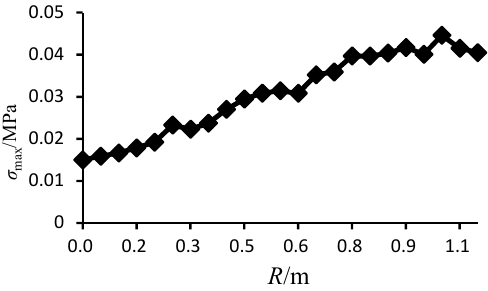
Figure 5. Suitability comparison diagram of four kinds of buoys.